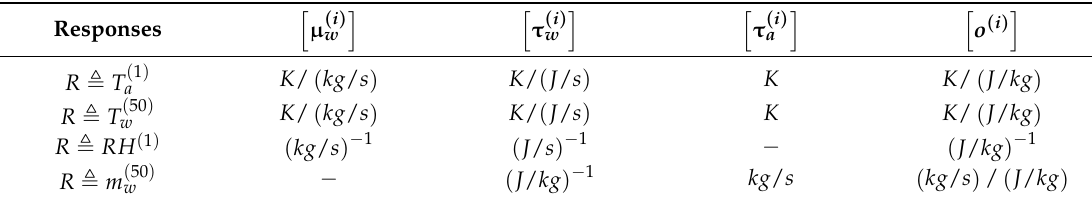
Table 1. Units of the adjoint functions for different